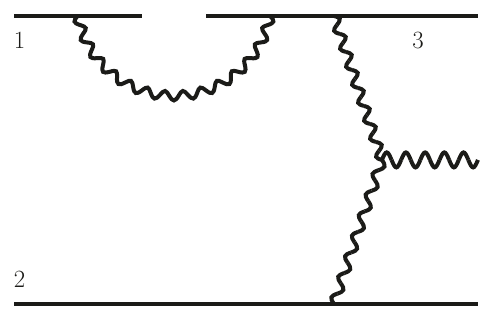
Figure 2 . A schematic diagram contributed to next-to-leading order radiation in the same notation as (cid:12)gure 1. This becomes a self-energy correction to particle 1 with leading order radiation if we identify the particle 3 with particle